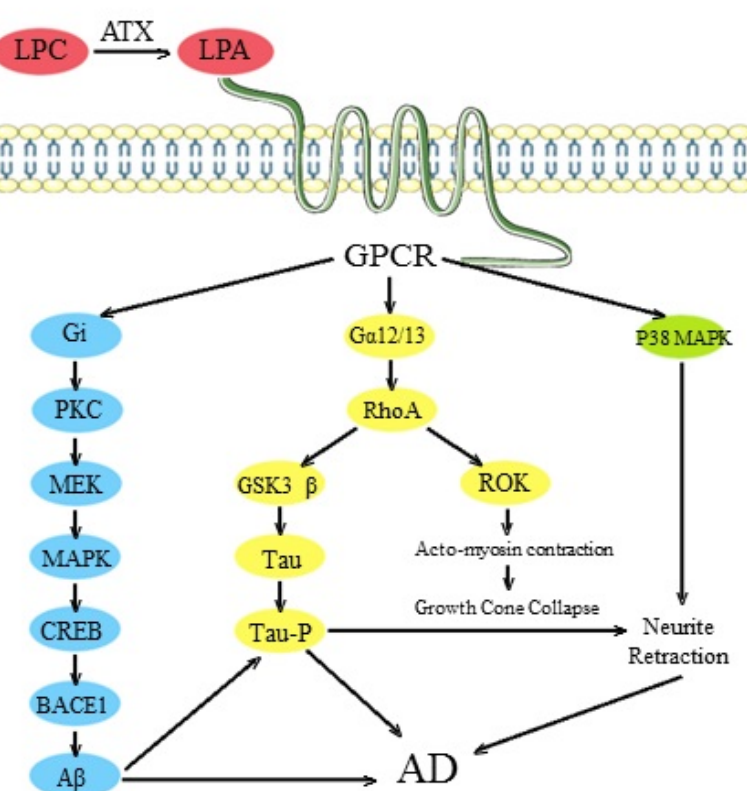
Figure 1. Autotaxin (ATX)–LPA-mediated downstream signaling leading to formation of amyloid- β (A β ), hyperphosphorylation of tau, and neurite retraction all leading to the pathogenesis of Alzheimer’s disease (AD). GPCR, G protein-coupled receptors; PLC, Phospholipase C; PKC, Protein Kinase C; BACE1, β -Site APP-cleaving enzyme 1; CREB, cyclic AMP response element binding protein.